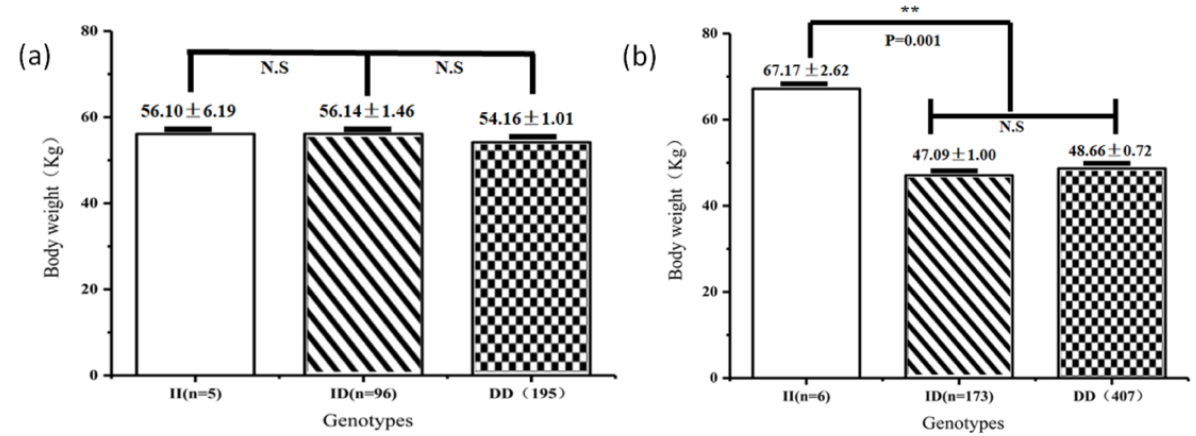
Figure 3. Association of the P1–7 bp ( a ) and P2–13 bp ( b ) indels with body weight in SWCG. Individuals with II genotypes had significantly ( p = 0.002) higher body weight than ID and DD in the 13-bp indel of AKAP12 . Data represents means ± SE. N·S means not significant; **: p < 0.01.